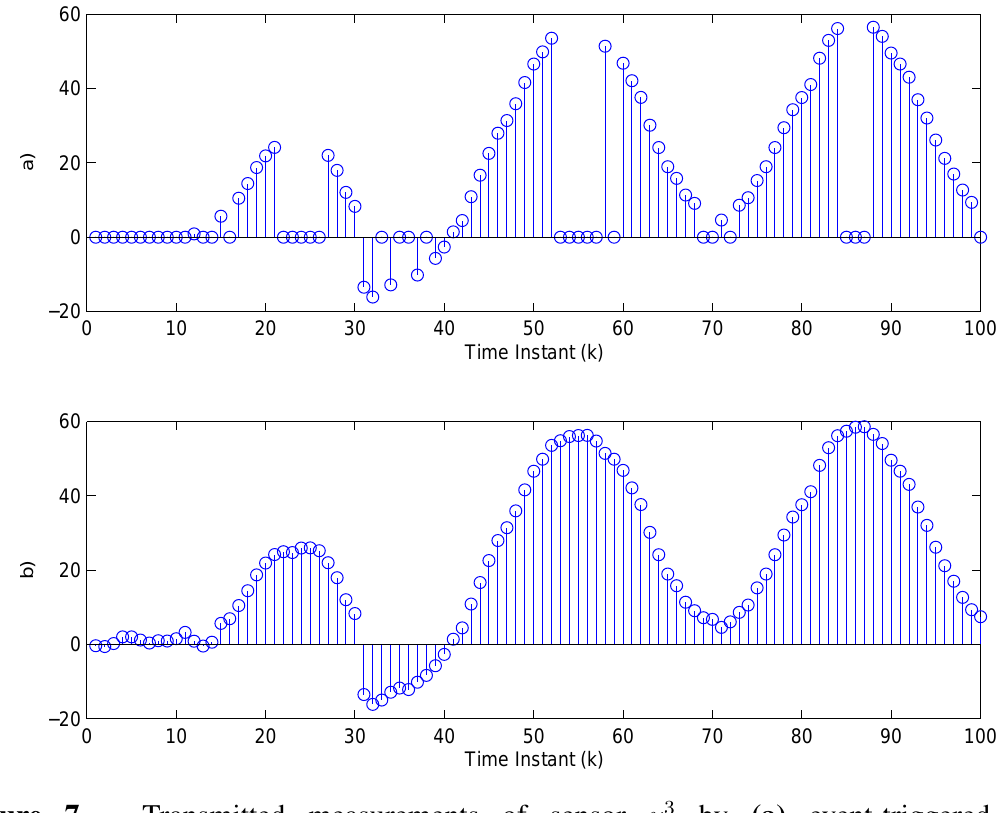
Figure 7. Transmitted measurements of sensor y 3 (b)